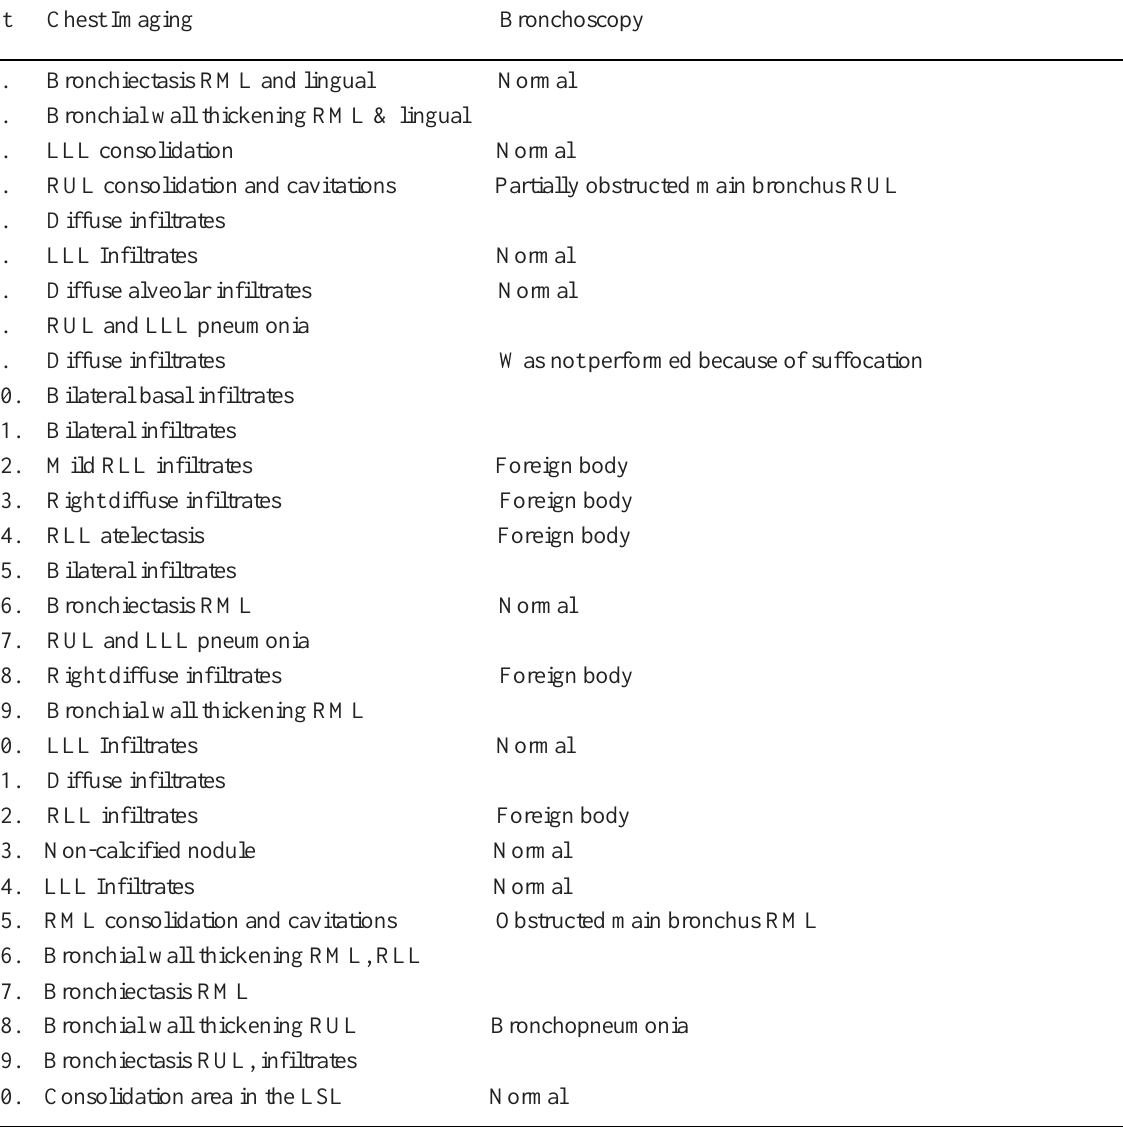
Table 3. Chest imaging and bronchoscopy of the patients with pulmonary hemorrhage. and cause of bleeding, and when foreign body aspiration was suspected.